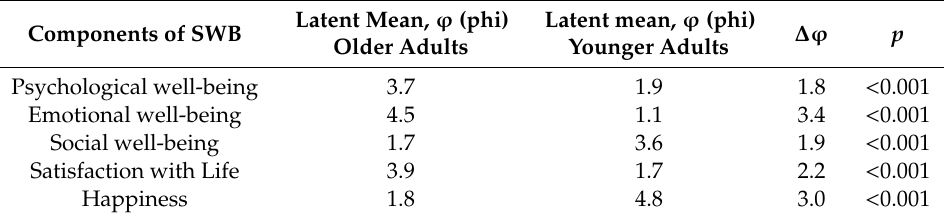
Table 5. Latent means for the age